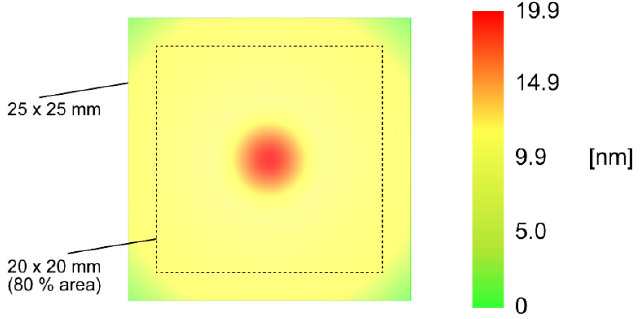
Figure 6. Calculated temperature distributions of the SiC ceramic substrate cooled from the lateral sides of the substrate at 22 °C. Calculated temperature distributions on the ( a ) lateral side surface and ( b ) mirror surface.